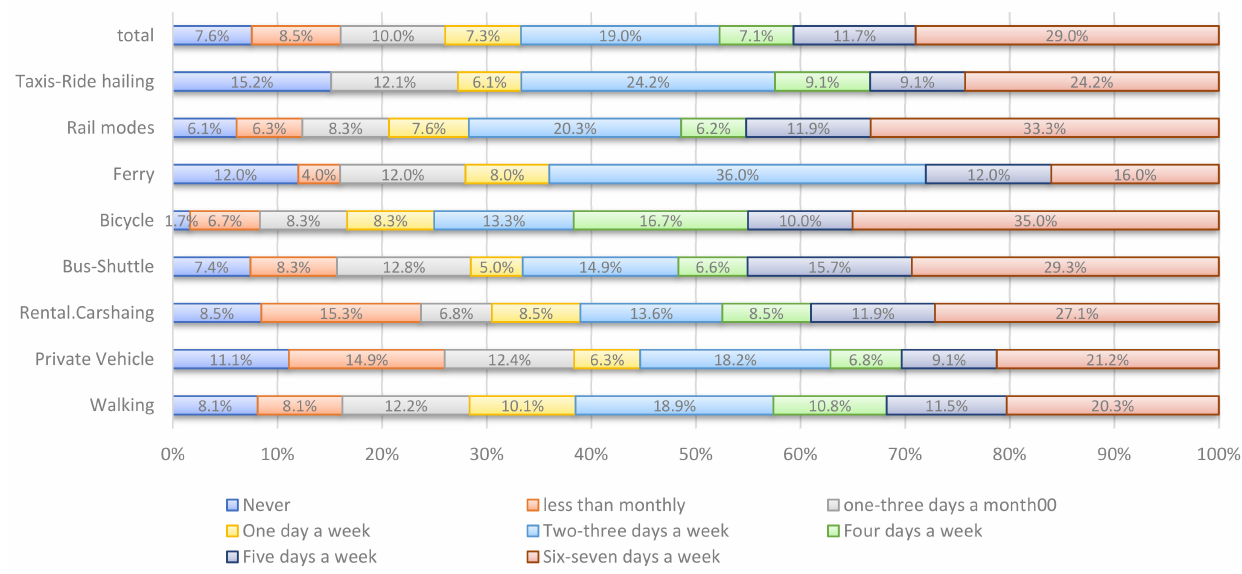
Figure 2. Frequency use of ATIS apps of participants for each main mobility mode.